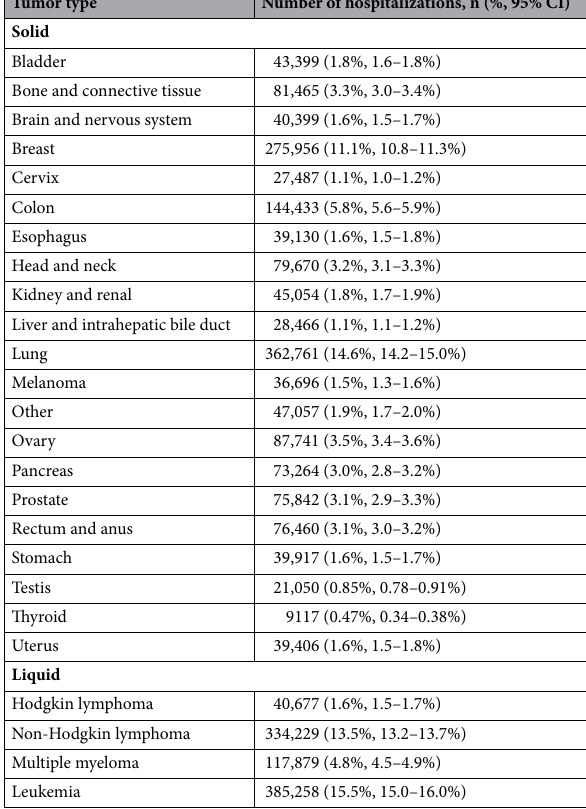
Table 1. Hospitalizations for complications of systemic therapy by tumor type, 2005–2016 (n = 2,419,722). *The total number of hospitalizations for all cancers considered together is be less than the sum of the hospitalizations for individual cancers because some patients had multiple